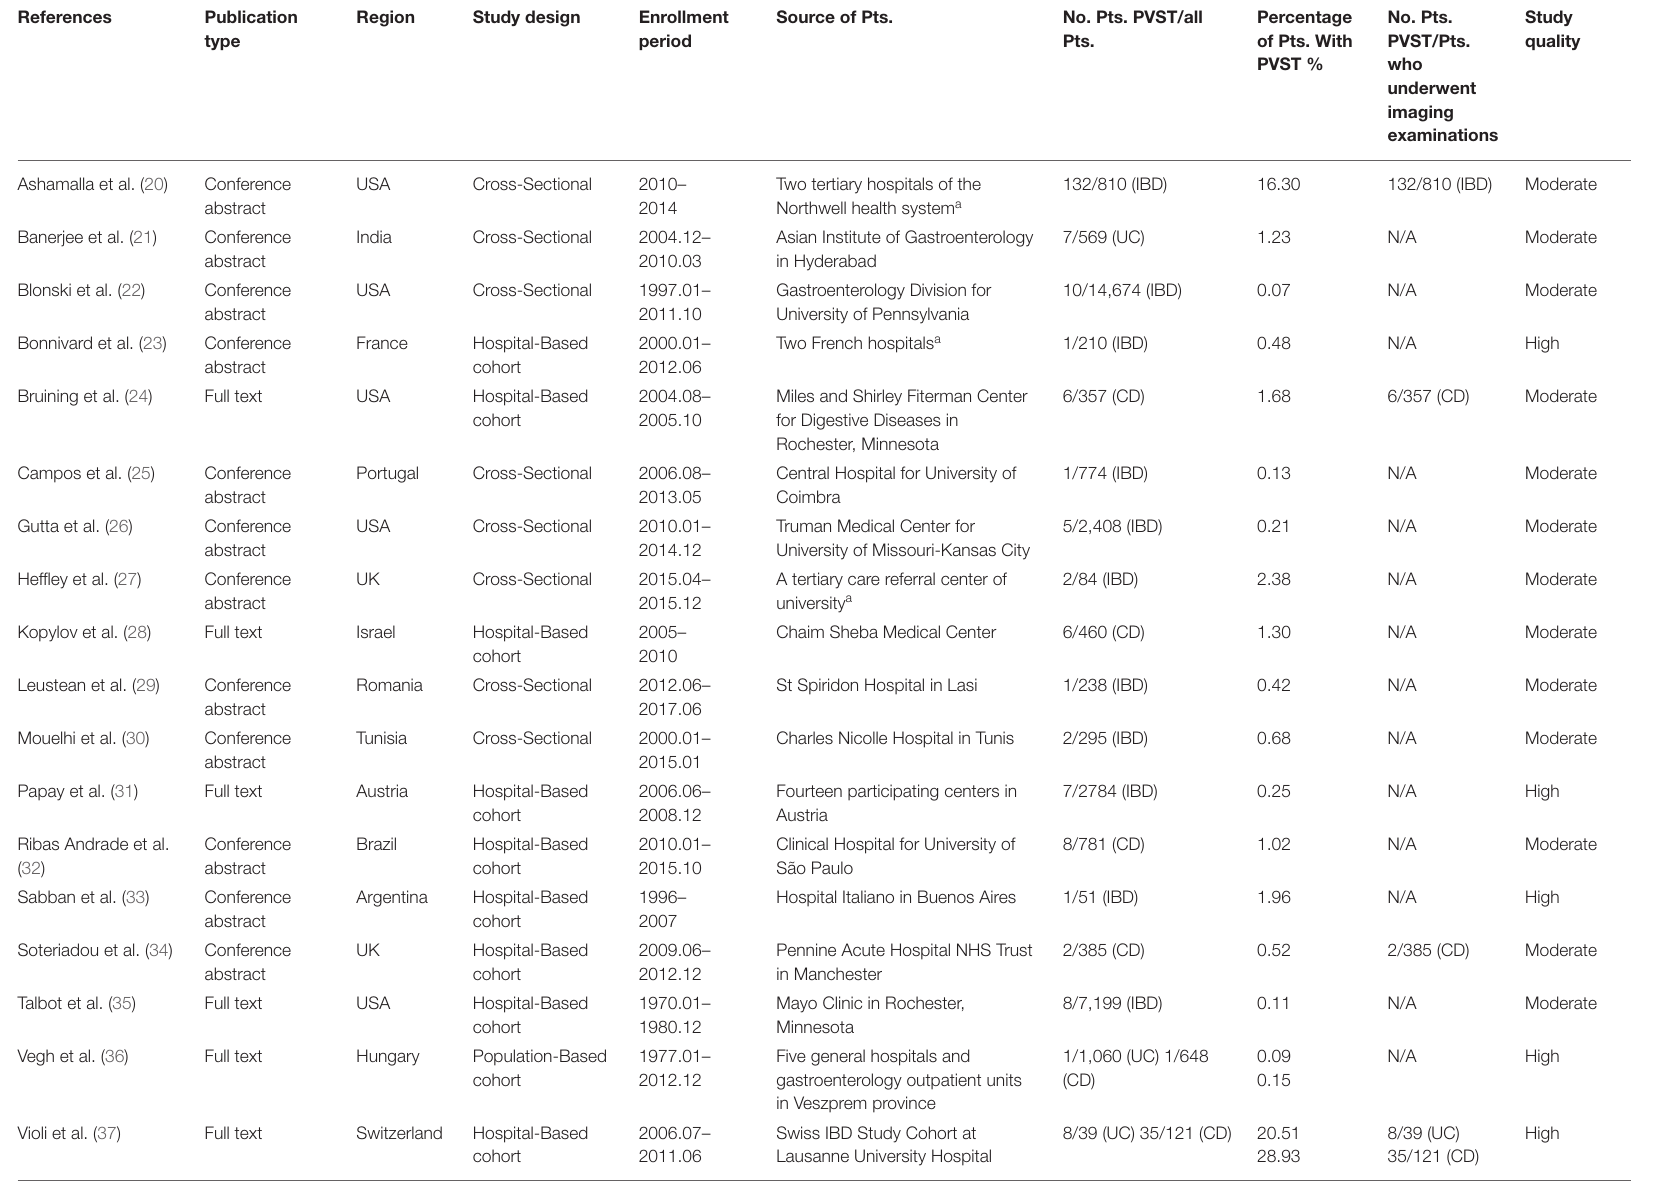
TABLE 1 | Characteristics of studies where the information with respect to colorectal surgery was